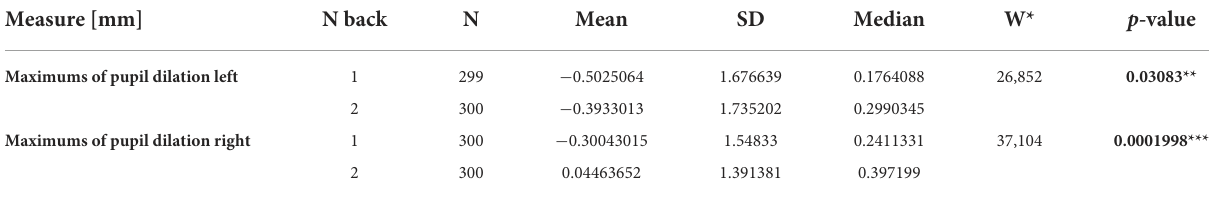
TABLE 6 The descriptive statistics and Mann–Whitney–Wilcoxon test results for the maximum pupil dilation left and the maximum pupil dilation right between 1 and 2 back.